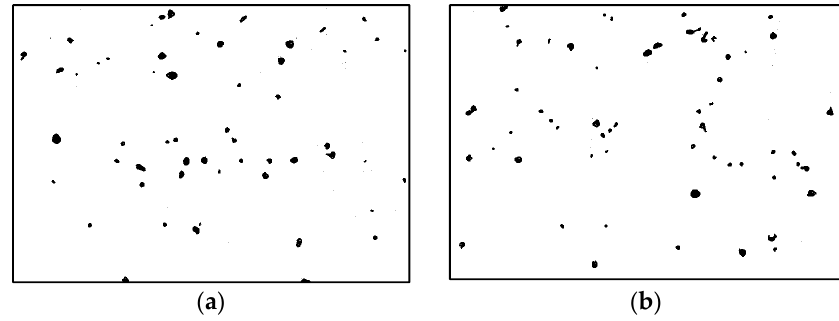
Figure 3. Distribution and geometry of microvoids extracted from SEM images. ( a ) From 1-R; and ( b ) from 2-R microstructure in Table 1.